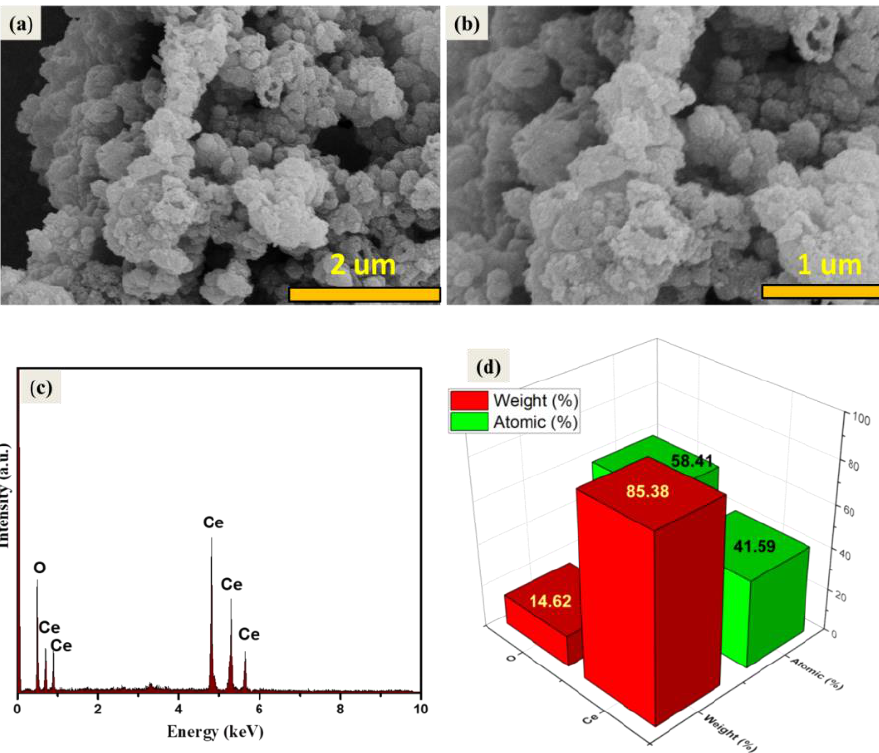
Figure 2. SEM images ( a , b ), EDX spectrum ( c ), and elemental composition ( d ) of the synthesized CeO 2 NPs.